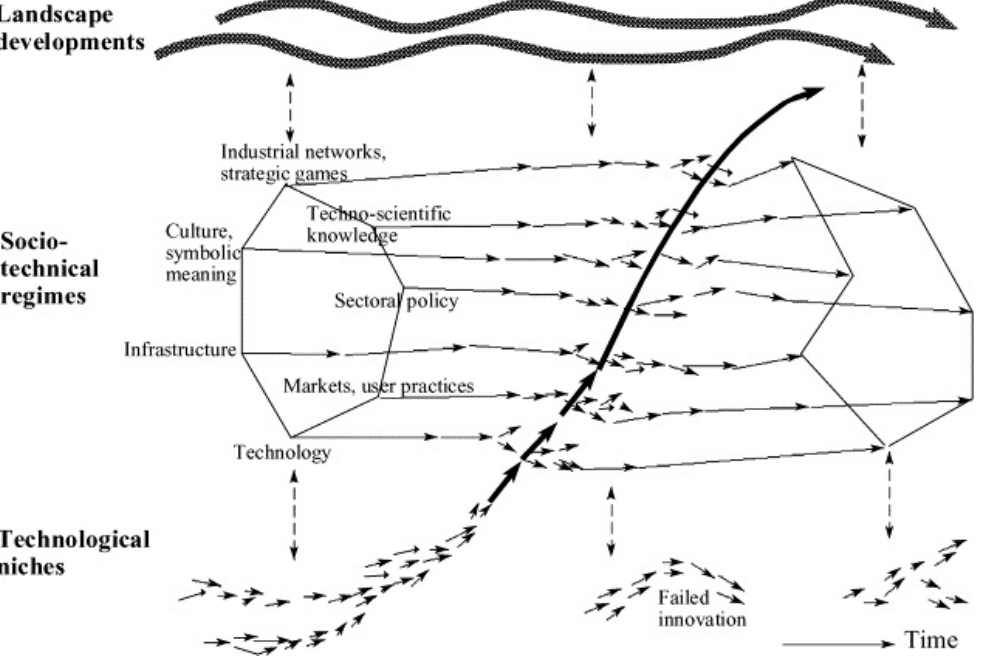
Figure 1: A multi‐level perspective of the development and break‐through of a niche innovation over time (source: (Geels et al.